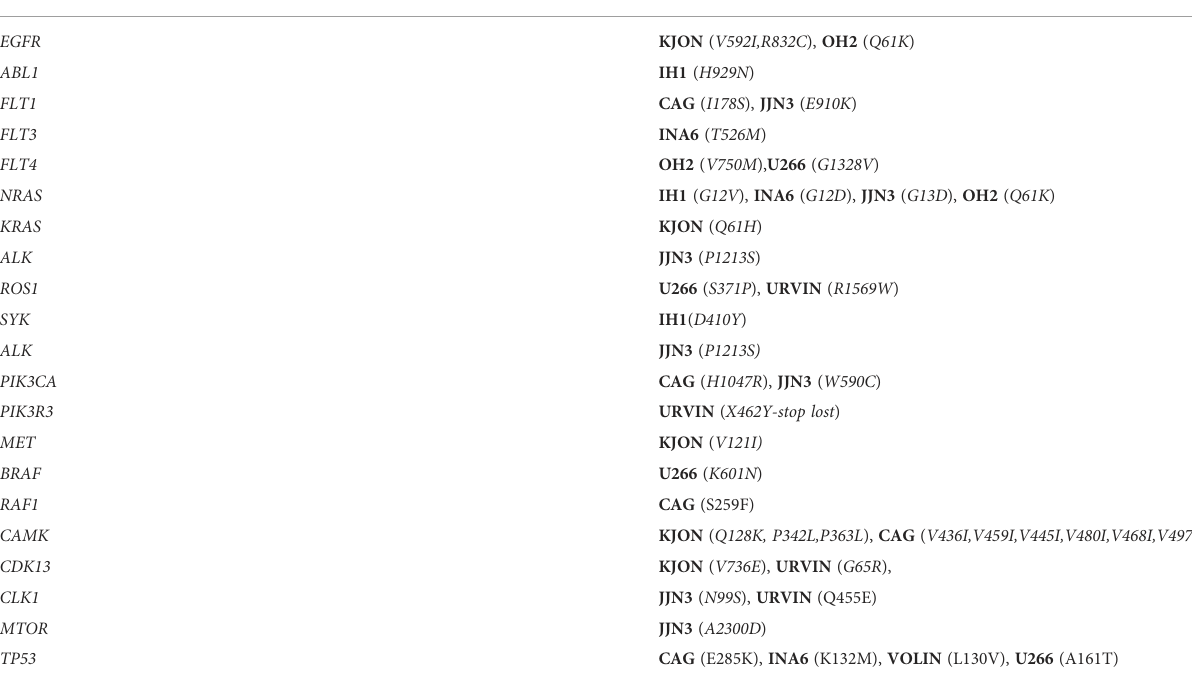
TABLE 2 MM cell lines included in the study and amino acid changes detected in mutated genes. Mutated gene